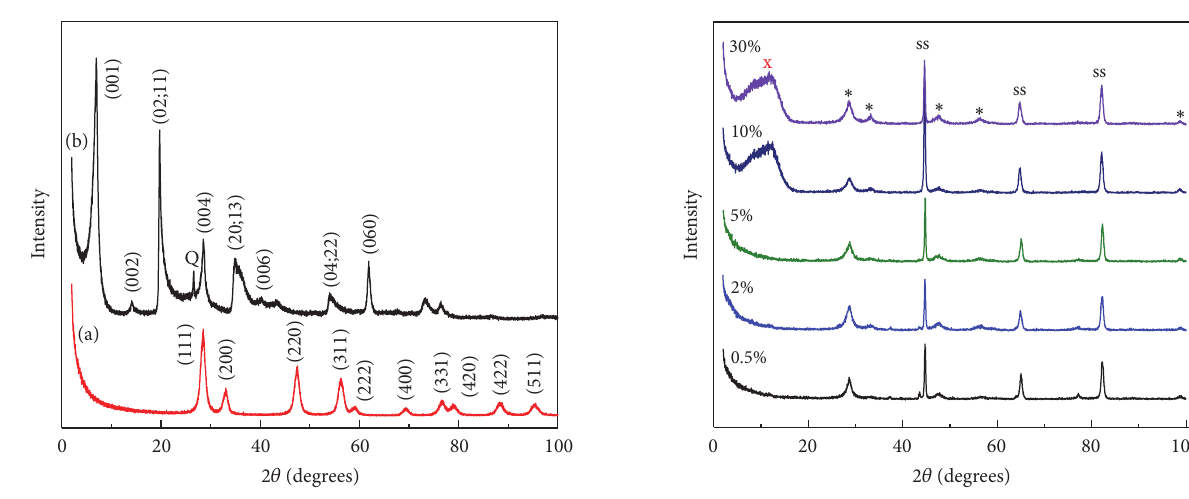
Figure 3: X-ray diffraction patterns of CeO 2 /MMT nanocomposite films deposited from 0.5, 2, 5, 10, and 30% MMT concentrations in the plating solution ( ∗ represents the cerium oxide reflections, and red x represents the 00 𝑙 reflections for the layered